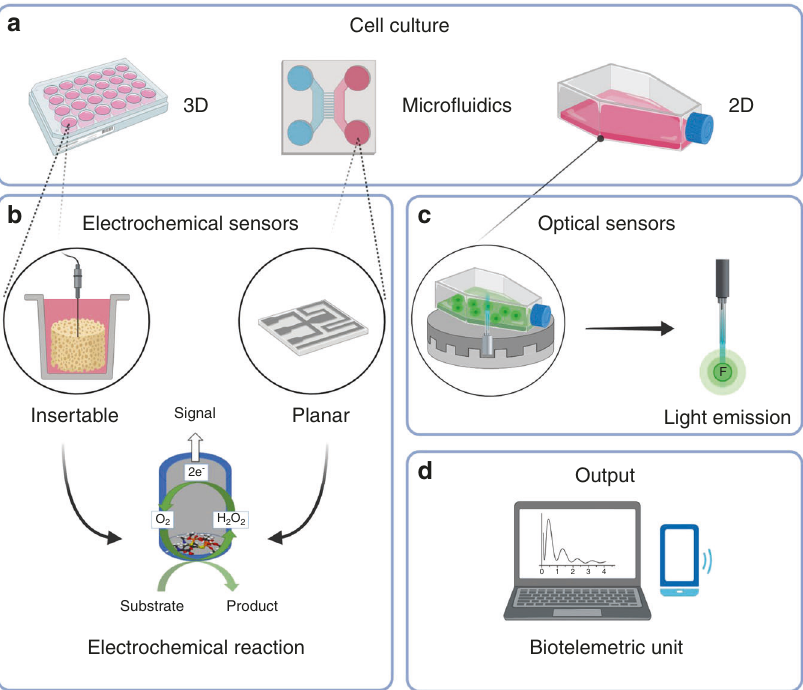
Fig. 7 Overview of the applicability of sensors to the fi eld of tissue engineering. Critical parameters for construct quality control (e.g., glucose, lactate, and oxygen consumption) could be monitored in different types of in vitro culture systems ( a ) by using electrochemical ( b ) and optical ( c ) sensors/biosensors for real-time quality monitoring ( d ). These methods are conservative, allowing for longitudinal studies and further applicability of tissue engineered